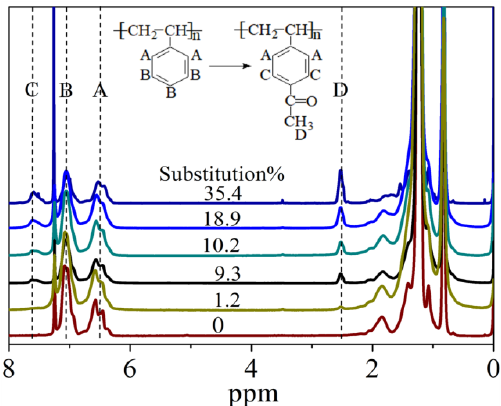
Figure 2. Nuclear Magnetic Resonance Hydrogen (NMR) hydrogen spectra of SEBS with different Acetylation Degrees.